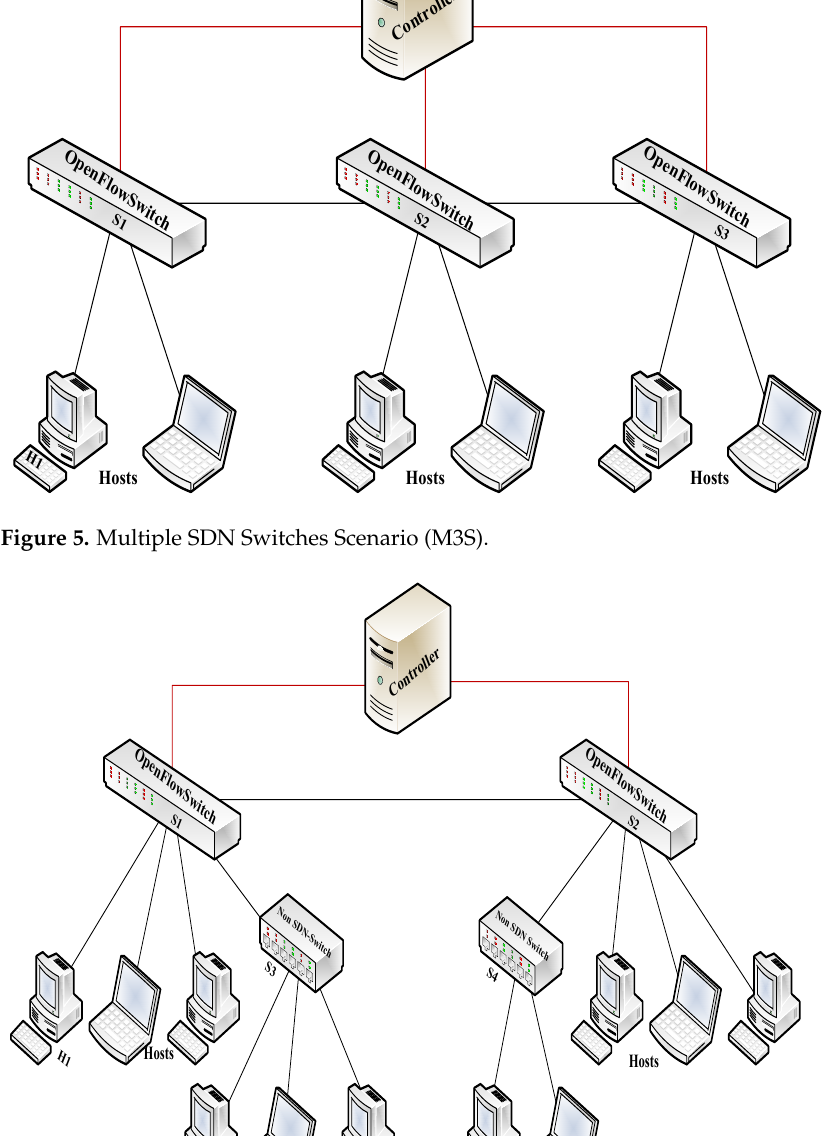
Figure 6. Hybrid SDN Switch Scenario (H3S).